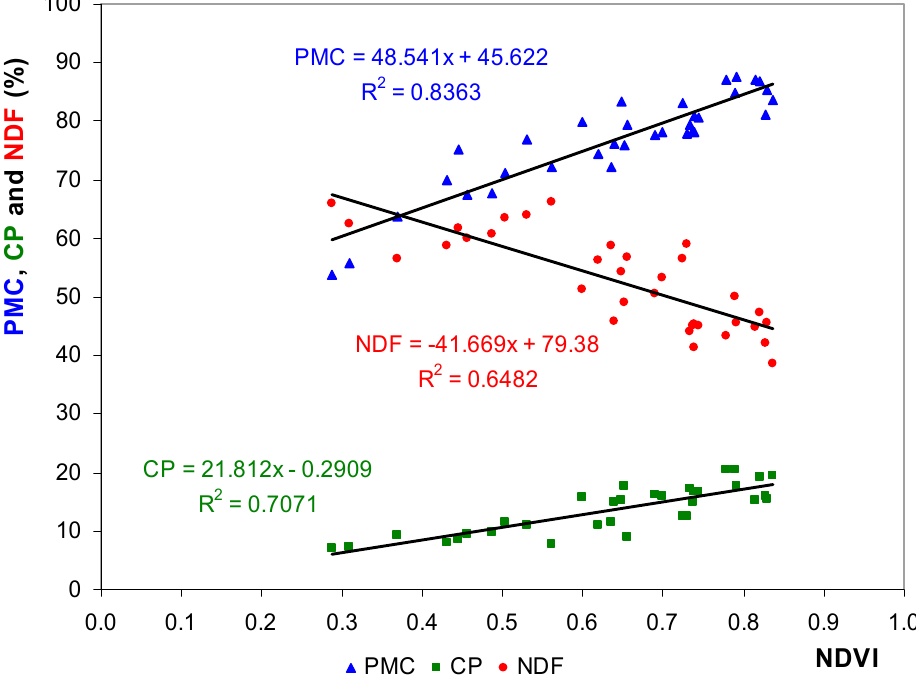
Figure 10. Reference values of pasture moisture content (PMC), crude protein (CP) and neutral detergent fiber (NDF) obtained in laboratory versus normalized difference vegetation index (NDVI) measurements carried out by the optical sensor OptRx.